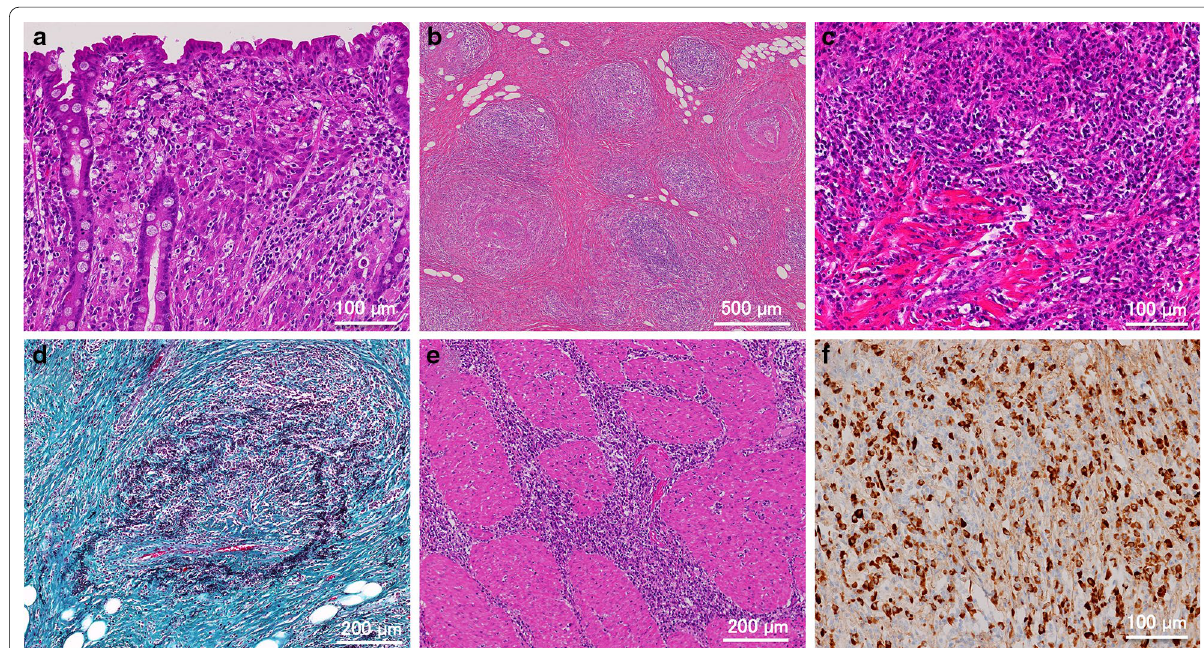
Fig. 3 a Poorly differentiated adenocarcinoma with signet-ring cells had proliferated within the lamina propria (HE; original magnification, b The submucosal layer was expanded by fibrosis, lymphoid follicles, obliterative phlebitis, and arteritis (HE; original magnification, and diffuse infiltrate of plasma cells and lymphocytes (HE; original magnification, 200). d Obliterative phlebitis is highlighted by Elastica staining × (Elastica-Masson; original magnification, 100). e Lymphoplasmacytic infiltrate is observed in the interstitium of the muscularis propria (HE; original × magnification, 100). f Immunostaining for IgG4 reveals infiltration by a large number of IgG4-positive plasma cells (original magnification, ×